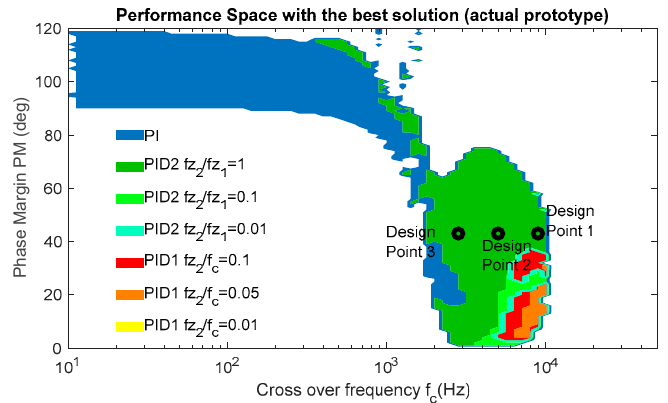
Figure 13. Performance space for the actual prototype with the best solution for each point.